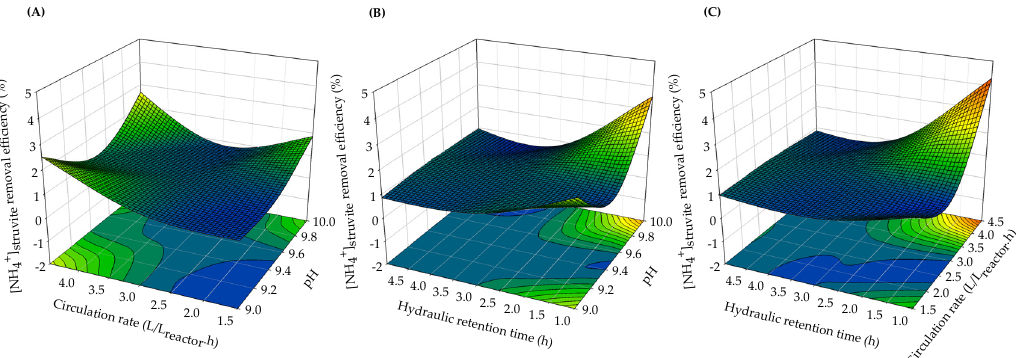
Figure 3. 3D response surface plots showing the effects on NH 4 -N recovery of: ( A ) pH × circulation rate, ( B ) pH × hydraulic retention time, and ( C ) circulation rate × hydraulic retention time.